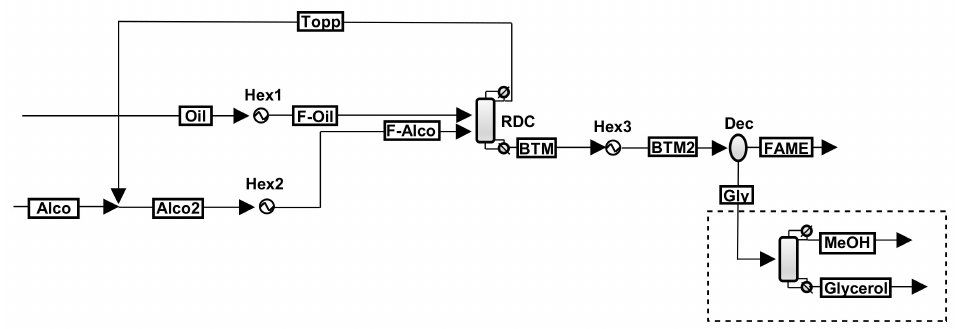
Figure 15. Biodiesel production with reactive distillation column using heterogeneous